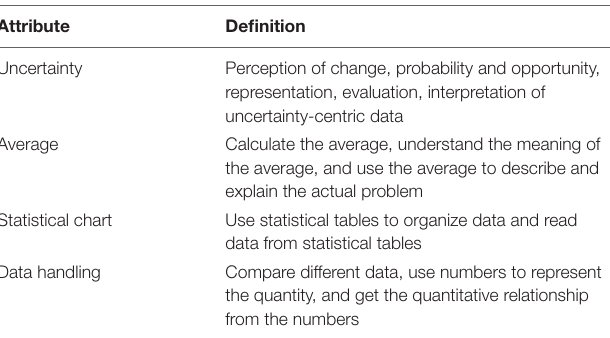
TABLE 1 | Dimensions of cognitive